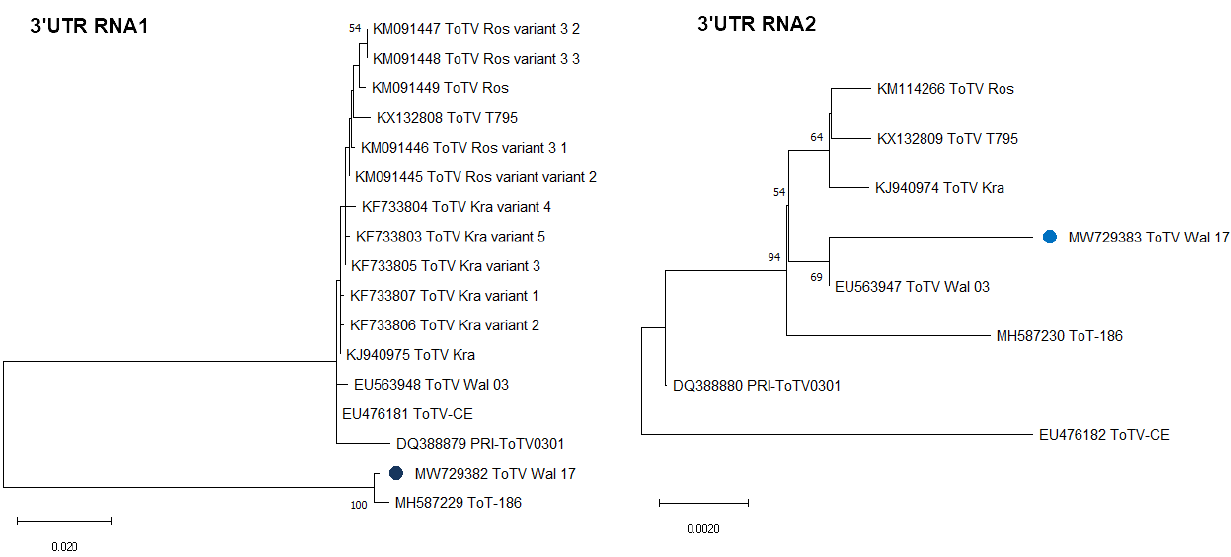
Figure 2. The phylogenetic analyses of 3’untranslated region of RNA1 and RNA2 of ToTV Wal’17. The dendrograms were generated and visualised in MEGA X software, using the maximum likelihood method and 1000 bootstrap value. The scale bars represent a genetic distance. A blue dot indicates the Wal’17 isolate. The accession numbers of sequences deposited in the GenBank NCBI used in analyses are indicated in the